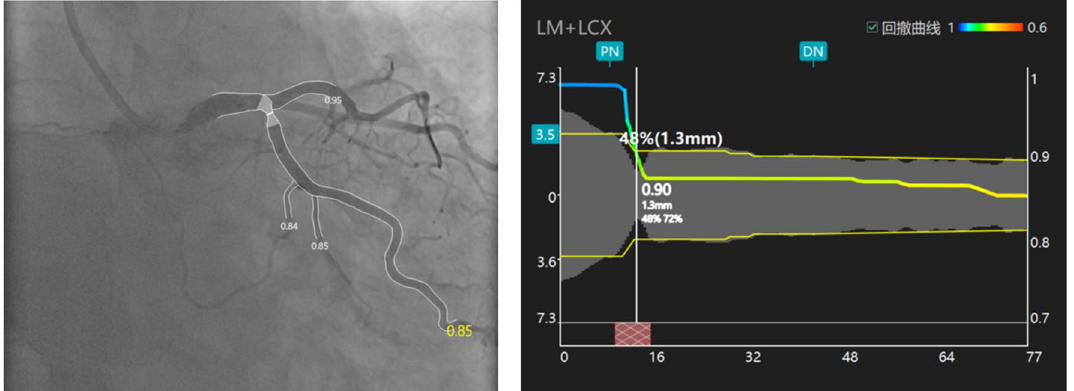
Figure 5. A representative example of computation of QFR. Left panel shows a stenosis at the ostium of LCX after LM-LAD stent implantation. The lumen contours of LM-LCX and its side branches were automatically delineated and superimposed on the angiographic images. The computed QFR was 0.85. Right panel shows the co-registration between lumen size and QFR pullback at every position along the